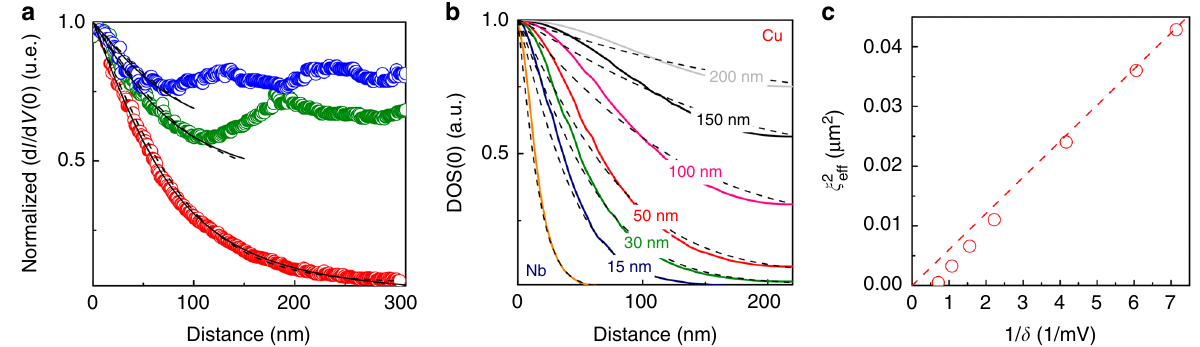
Fig. 4 Extracting the effective coherence length in Cu. a Red, green and blue data points: radial ZBC pro fi les of proximity vortex measured in magnetic fi elds of 5, 55, and 120 mT, respectively. Dashed lines: fi ts using phenomenological formula suggested in ref. 51 ; Solid lines: fi ts using modi fi ed de Gennes ’ approach developed in ref. 50 . Both models fi t well the experimental with ξ eff = 105 – 110 nm (see in the text). b Color lines: vortex core pro fi les (zero-bias conductance) calculated within Usadel framework for different thicknesses of Cu- fi lm in 5 mT fi eld. Dashed lines — best fi ts using the approximate formula (cid:3) 1 = suggested in 51 (see in the text). c The ξ eff vs δ plot presented in ξ 2 eff